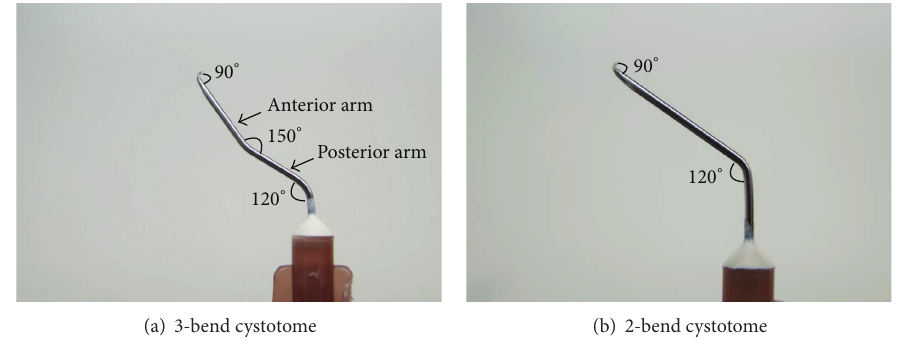
Figure 1: Demonstration of 2- and 3-bend cystotomes. Compared to the 2-bend cystotome, the 3-bend cystotome has one more bend at the middle point of the syringe needle. The three bends are 90 ∘ at the bevel, 120 ∘ at the hub, and 150 ∘ at the middle point.